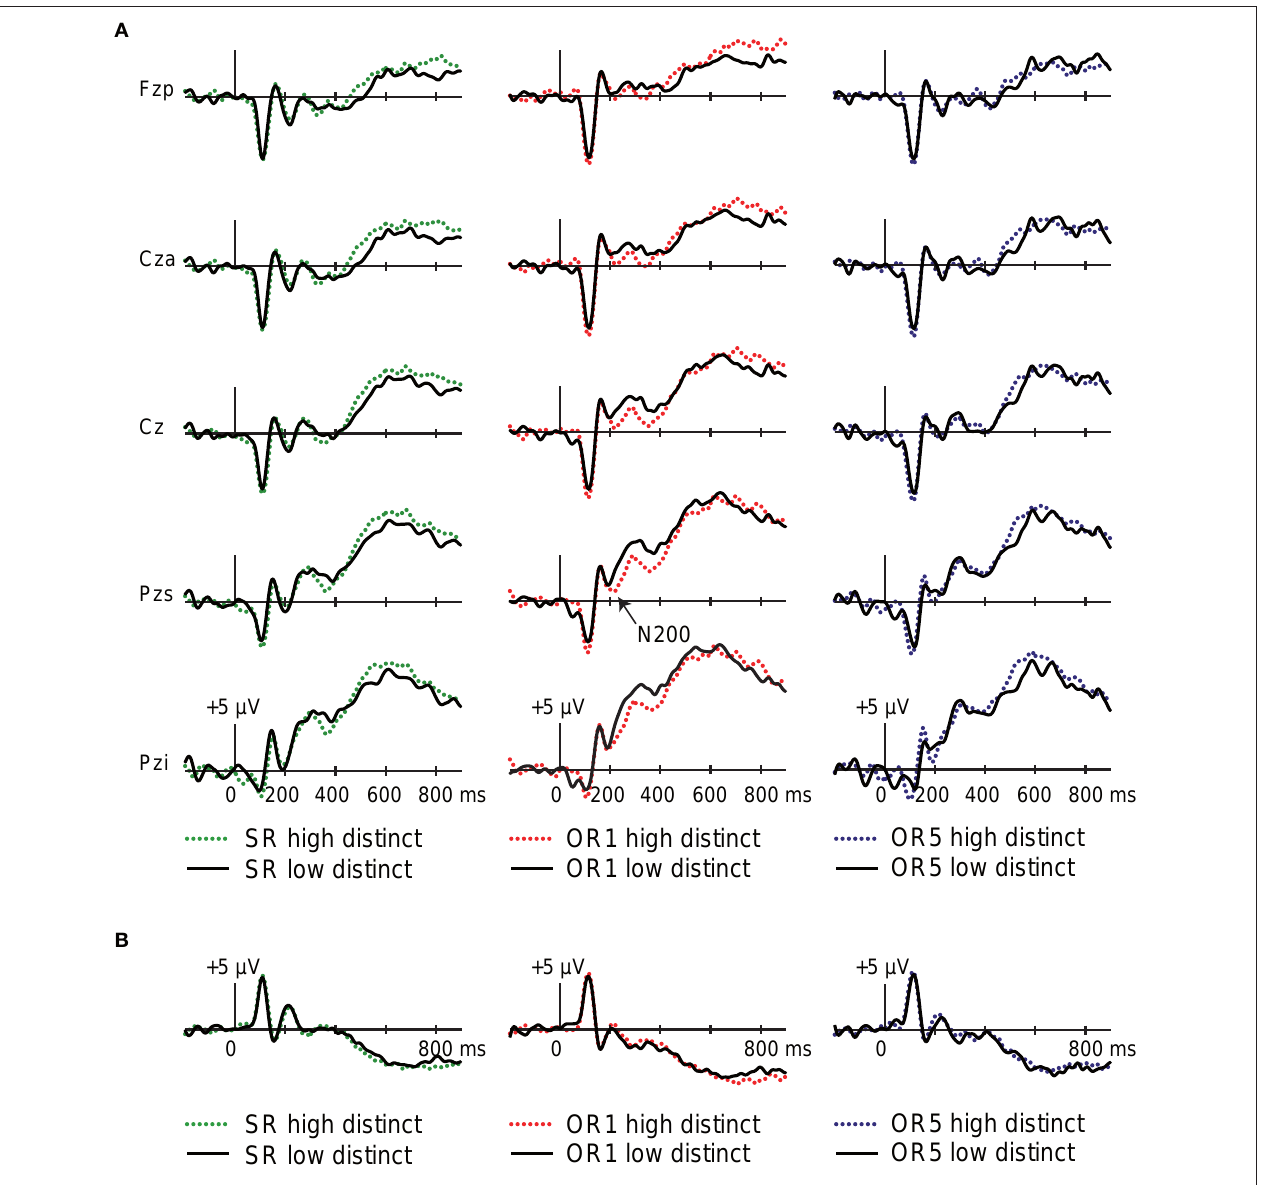
FiGuRE 7 | consensus distinctiveness effects on midline ERPs. Trials were divided via a median split into high-distinctiveness and low-distinctiveness categories for SR, OR1, and OR5 conditions (left, center, and right, respectively). (a) Waveforms for the same five midline electrode locations depicted in Figures 3 and 6 . (B) Waveforms from right-occipito-temporal electrode T2i, computed using averaged-reference